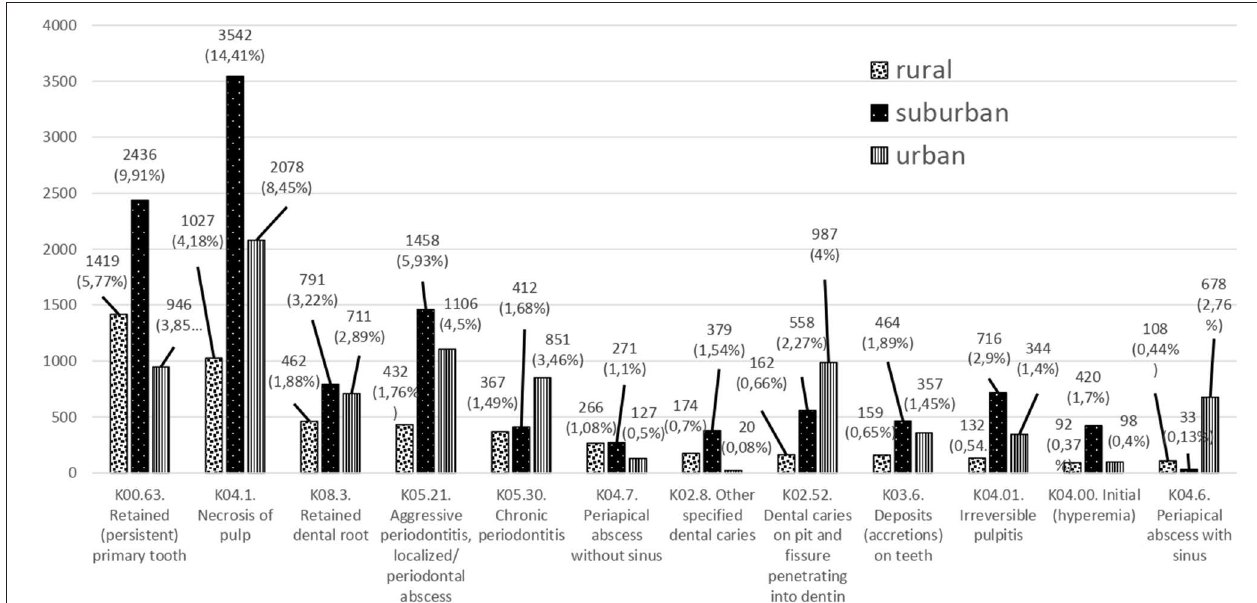
FIGURE 2 | Dental therapy patterns in urban, suburban, and rural areas of the Special Region of Yogyakarta in